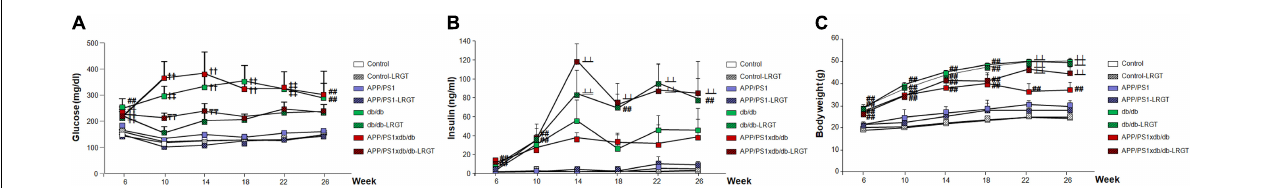
FIGURE 1 | Long-term liraglutide (LRTG) treatment ameliorates metabolic alterations in T2D and AD-T2D mice. (A) Non-fasting plasma glucose, (B) insulin, and (C) body weight were measured every 4 weeks in controls, APP/PS1, db/db and APP/PS1xdb/db mice treated with vehicle or LGRT 500 µ g/kg for 20 weeks (from weeks 6 to 26) (complete statistical analysis included as a Supplementary Material ). (A) LRGT significantly reduced postprandial glucose levels in diabetic